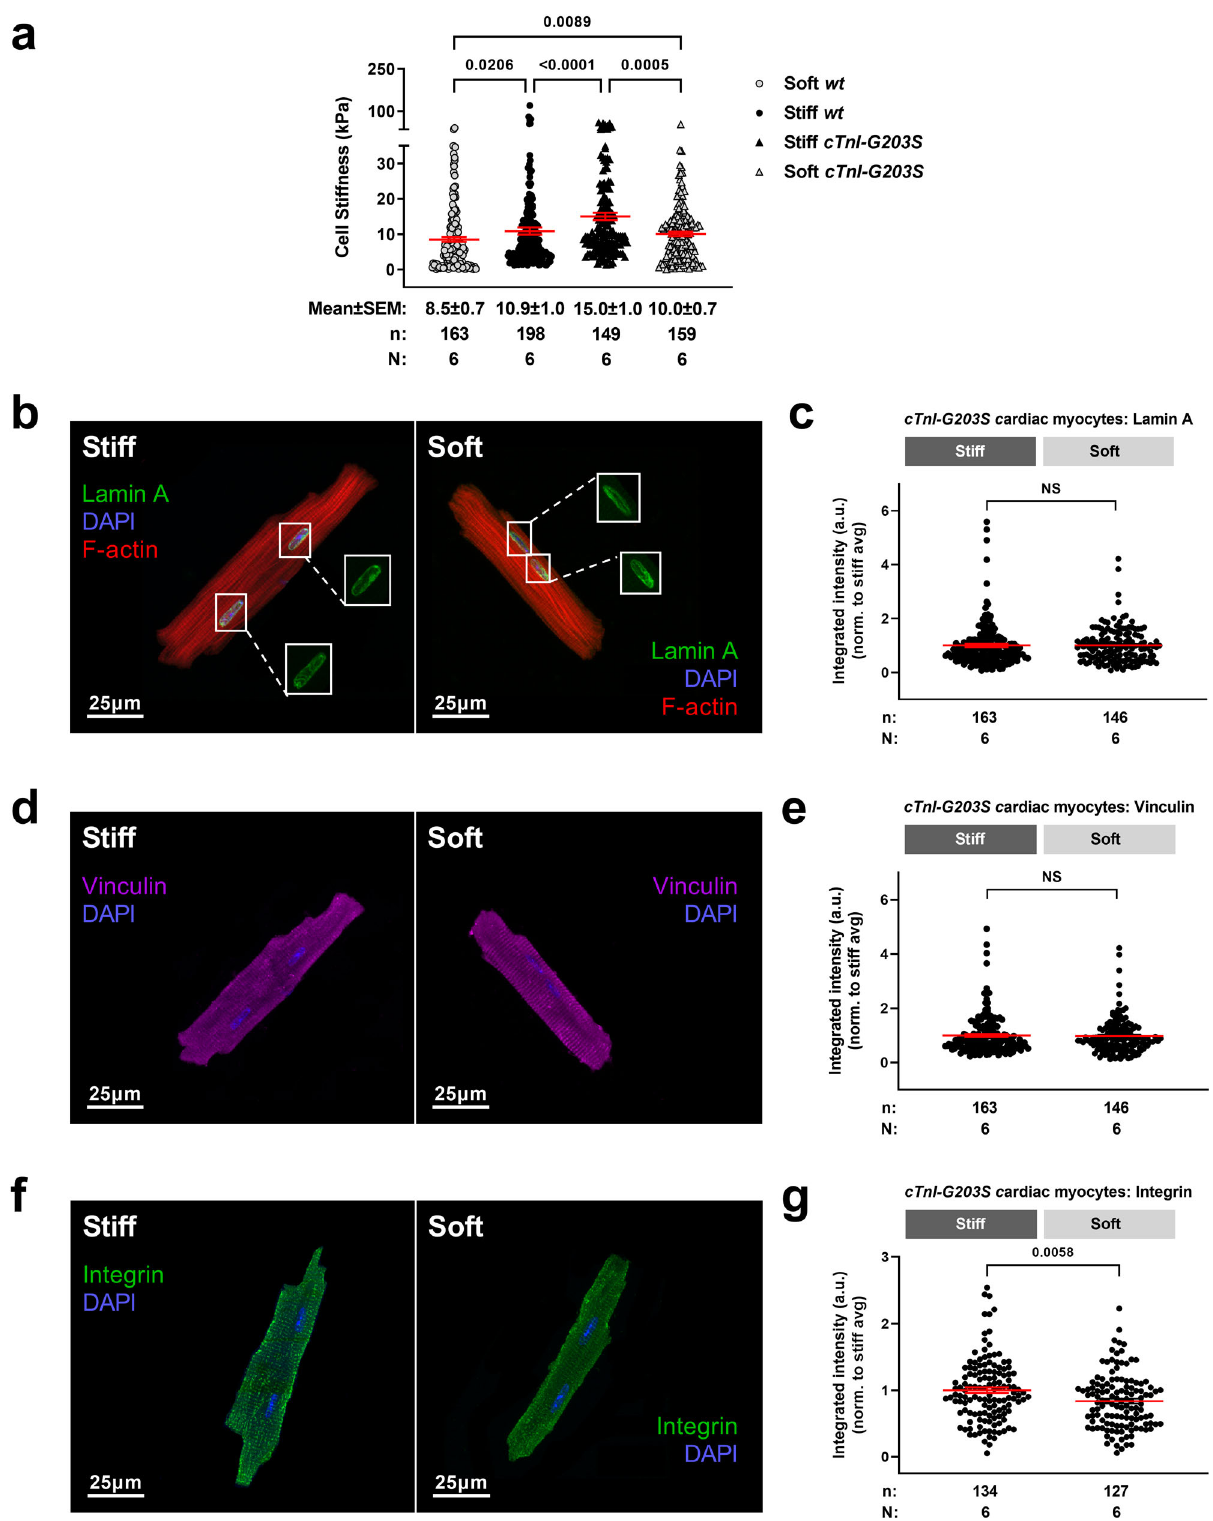
Fig. 5 Integrin is a key mechanosensing protein in cTnI-G203S myocytes. a Compressive stiffness (in kPa) of cardiac myocytes isolated from cardiomyopathic cTnI-G203S mice and wt counterparts plated on soft and stiff hydrogels, including mean±SEM. b – g Representative images and quantitated data points for cTnI-G203S cardiac myocytes plated on stiff and soft hydrogels stained for lamin A ( b , c ), vinculin ( d , e ), and integrin ( f , g ), including mean±SEM. n = number of cells, N = number of gels. All statistical signi fi cance determined by Mann Whitney tests, or by Kruskal-Wallis test ( a